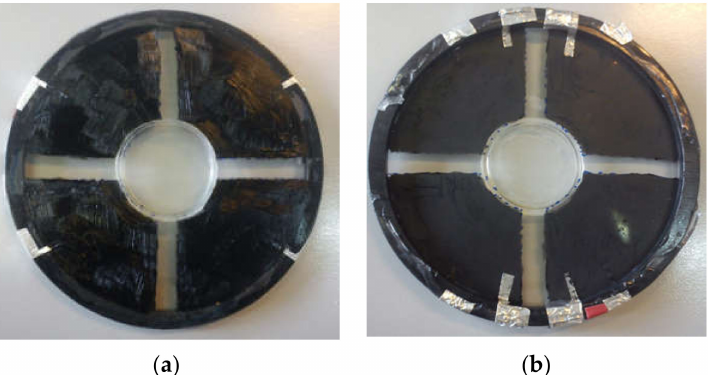
Figure 2. Elastomer film with four electrodes painted on each side, making a total of eight electrodes. An aluminum stripe is glued onto each electrode to make the electric contact with the driving circuit. ( a ) top view, featuring the PDMS ring glued in the center that encircles the passive zone of the device; ( b ) bottom view.